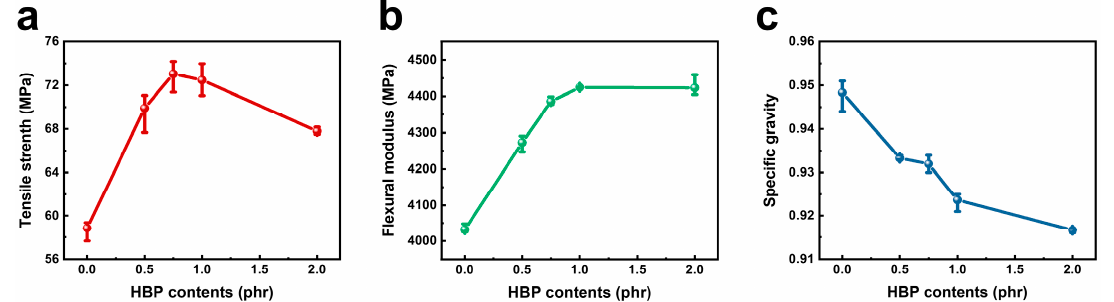
Figure 6. Tensile strength ( a ), flexural modulus ( b ), and the specific gravity ( c ) of the RSF with various contents of HBP. Table 4. Comparison of the mechanical properties of neat PA 6 and RSF containing various HBP